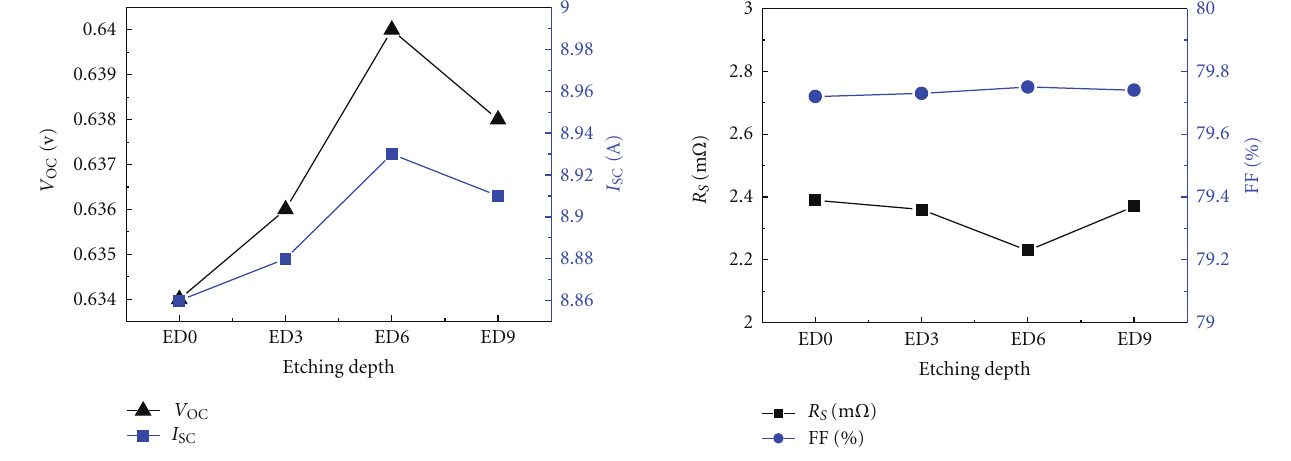
BSF and Al-Si alloy layer uniformities. The internal quantum e ffi ciency (IQE) response also reveals that higher etching depths have better responses at long wavelengths. Finally, the I - V tester presents that V OC and I SC of etching depths of 6 μ m ± 0.1 μ m is the best. This is due to a higher carrier lifetime contributed to by better long wavelength